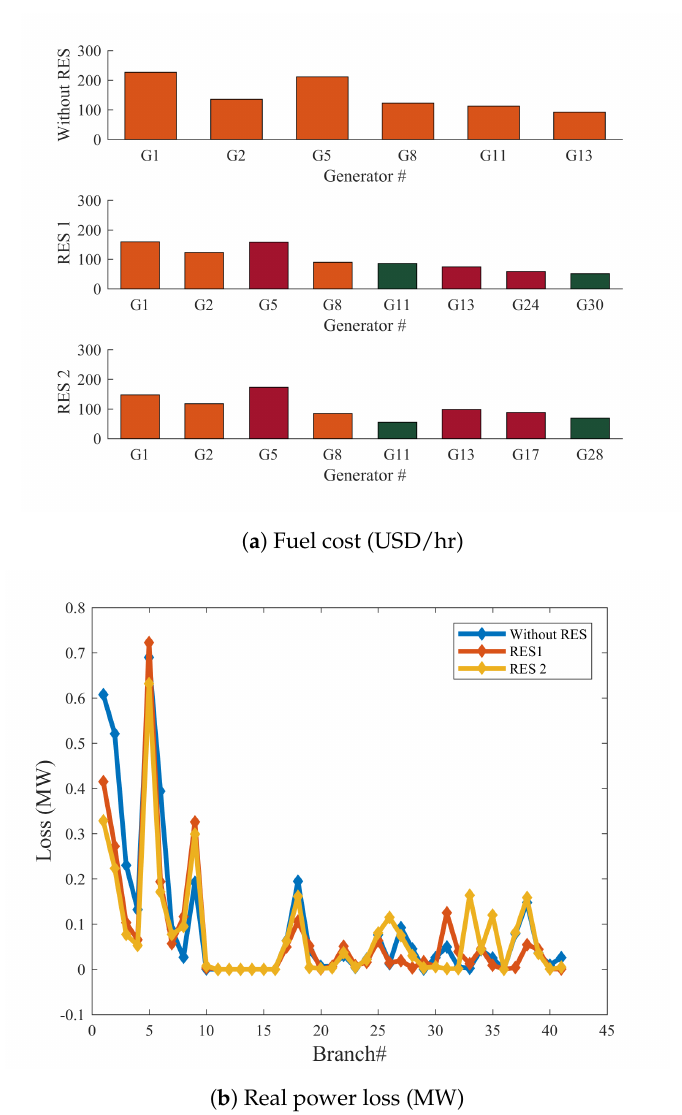
Figure 14. Fuel cost and Real power loss for case 9 for IEEE 30-bus system, IEEE 30-bus Modified (1) and IEEE 30-bus Modified